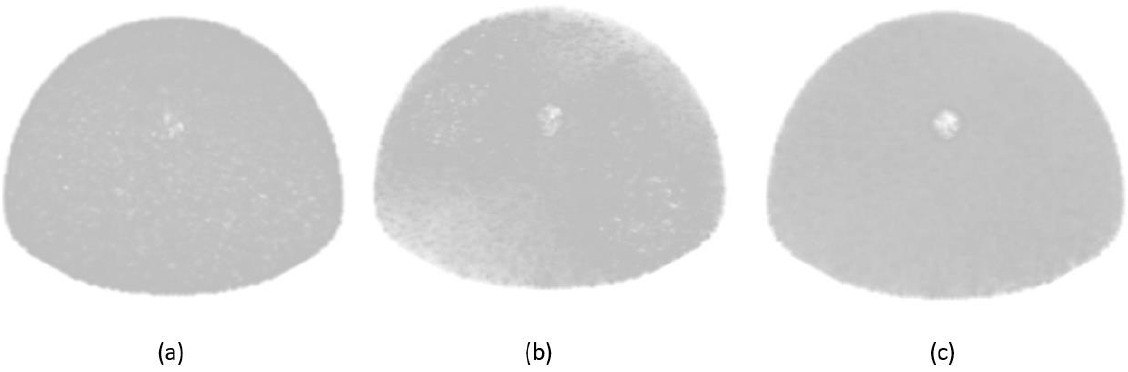
Figure 7. Reconstructed images of 3D breast with an 8 mm lesion: ( a ) using MURA mask/antimask, ( b ) using mosaic MURA mask, and ( c ) using mosaic MURA mask/antimask.